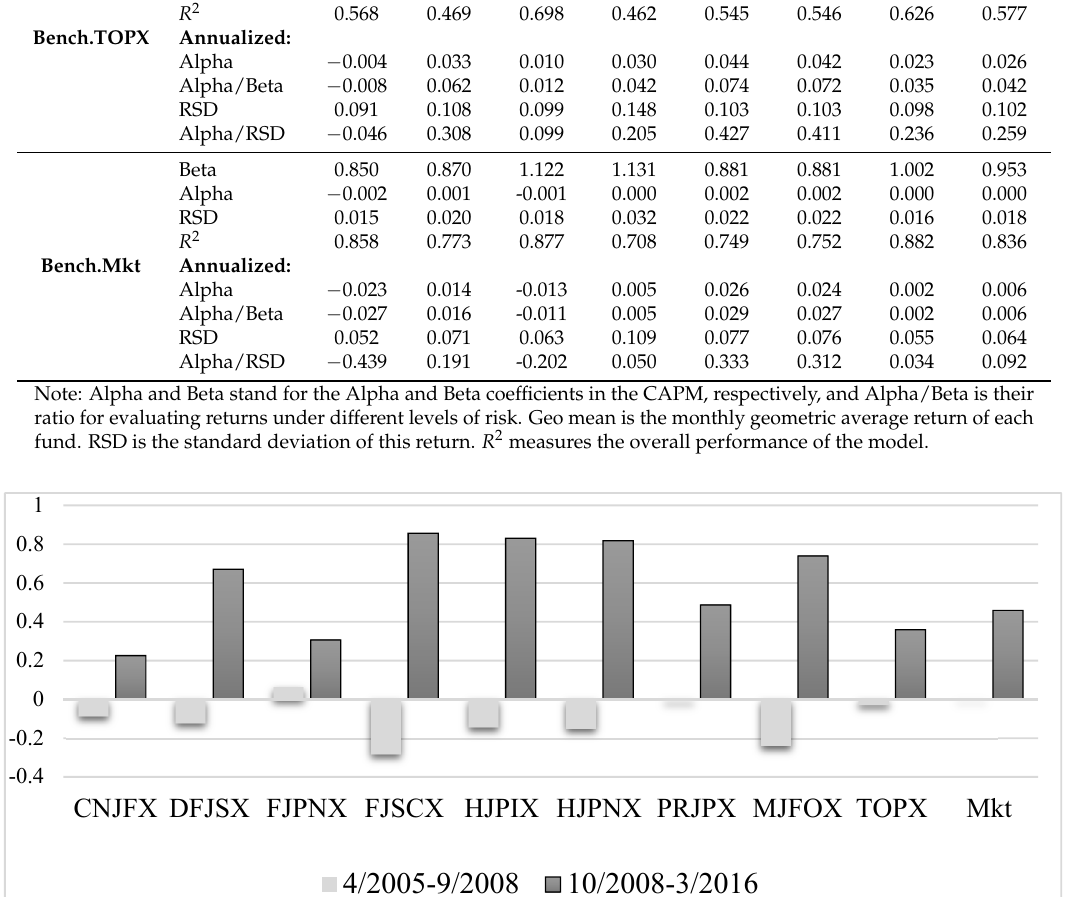
Table 4. Regression of mutual funds’ excess returns with TOPX and Mkt as benchmarks from